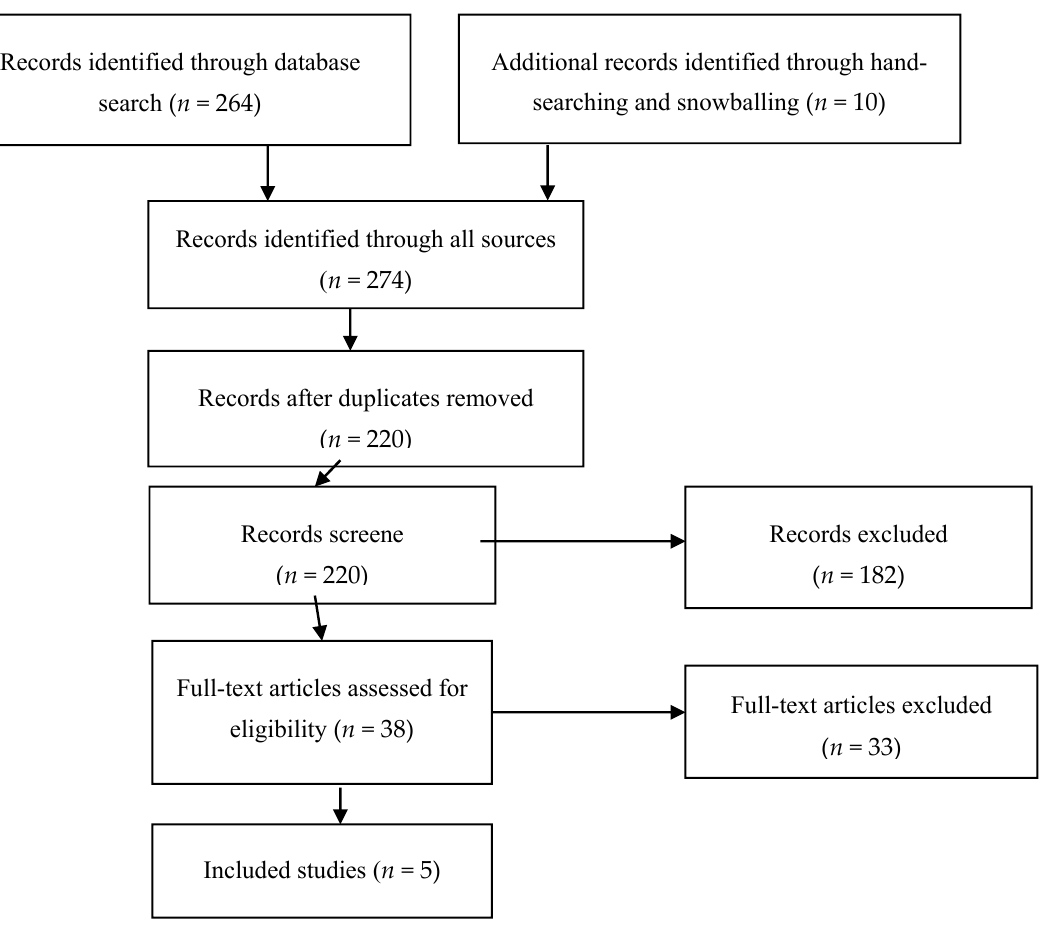
Figure 1. Flowchart of assessment of eligible studies.